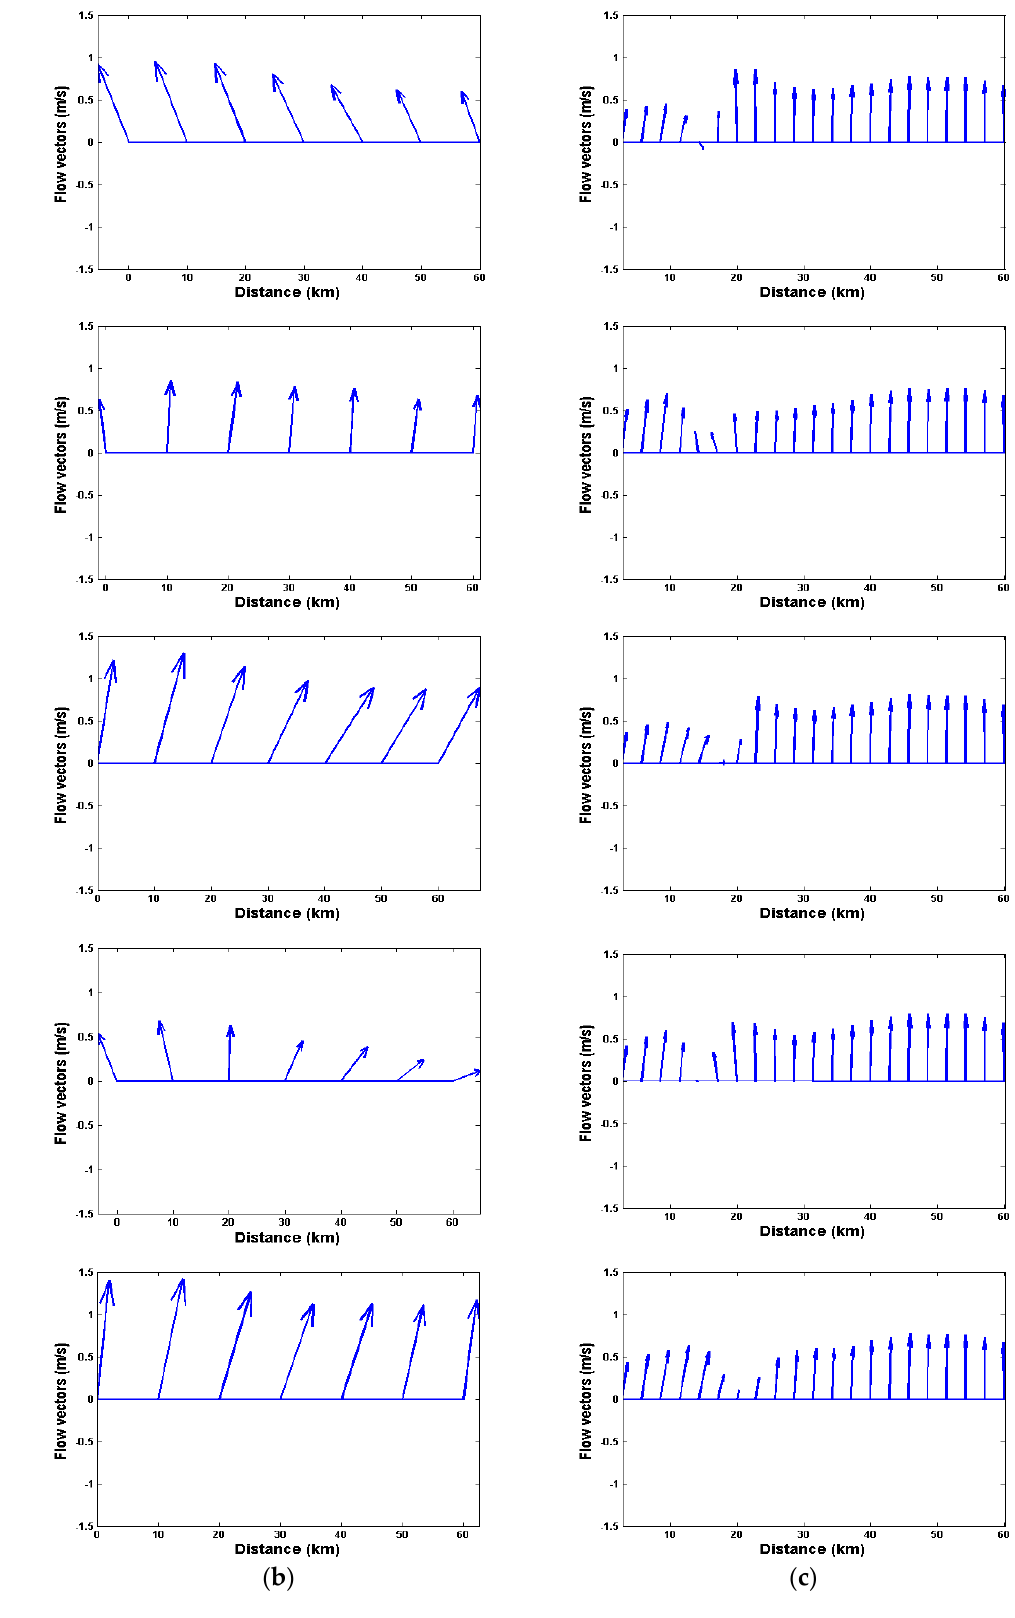
Figure 7. ( a ) Location of the 22.84° N ( y = 150 km) cross section, where black dots denote the position of TOROS data. ( b ) and ( c ) depict comparison of flow vectors of TOROS data and model predictions along 22.84° N cross section at S 0 – S 4 : five time instances, see Figure 5.